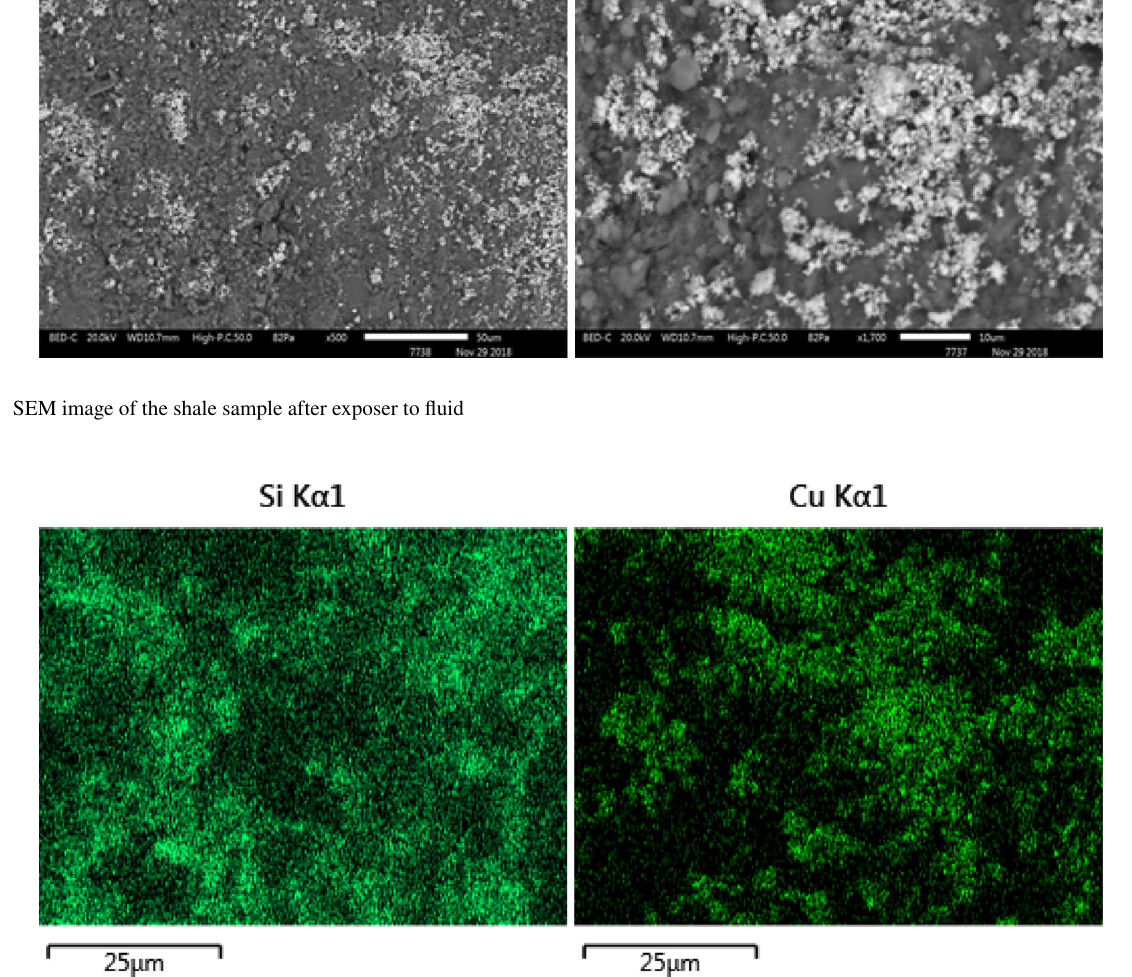
Fig. 9 EDS image showing the sample surface before (left) and after (right) being exposed to CuO